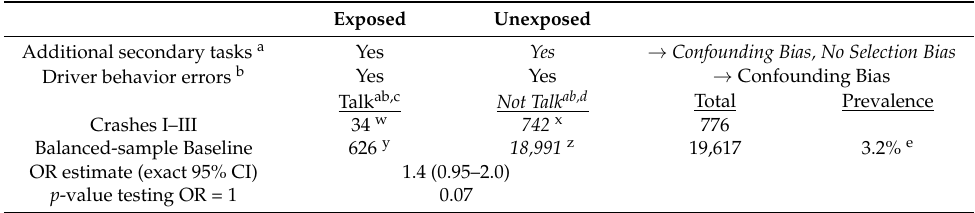
Table 4. Method 2 to remove “additional task” selection bias from Table